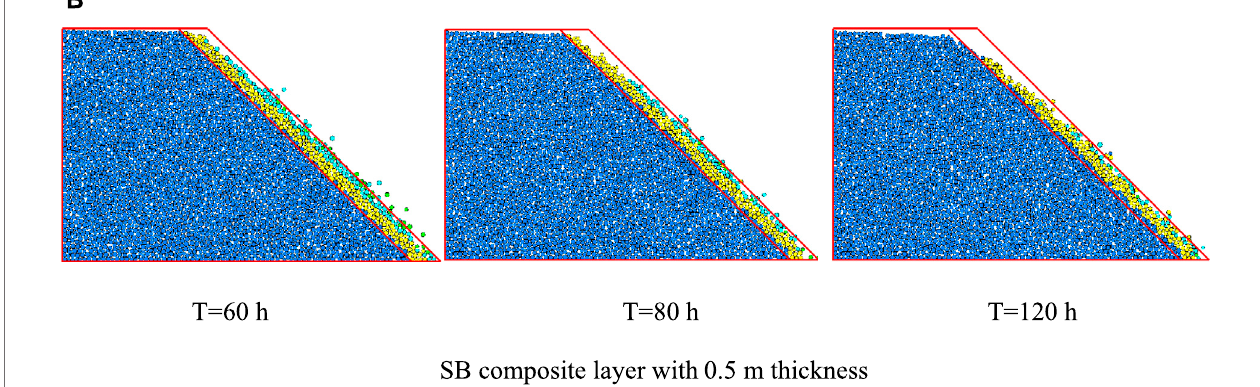
FIGURE 17 | Erosion failure modes of slope protected with different SB composite thicknesses. (A) SB composite layer with 0.3 m thickness. (B) SB composite layer with 0.5 m thickness